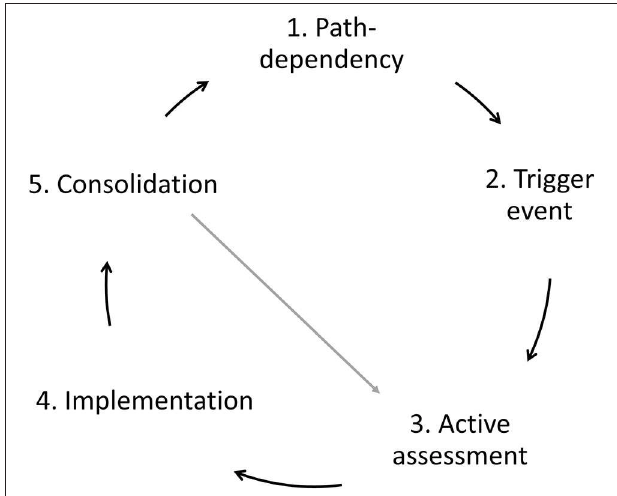
FIGURE 1 | The “Triggering change” model redrawn from Sutherland et al.